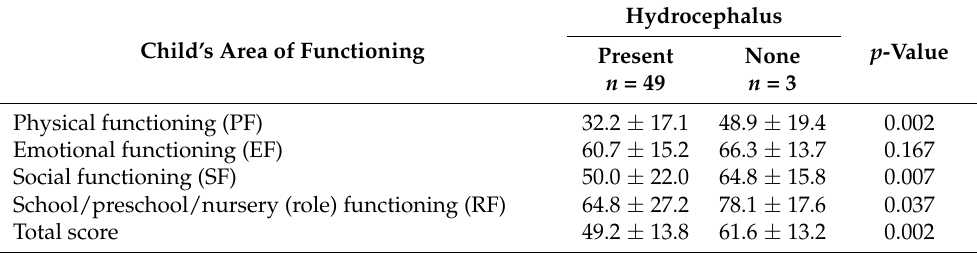
Table 5. Basic statistics (M ± SD) for children’s functioning scores, broken down by the presence or absence of hydrocephalus, with significance test results.